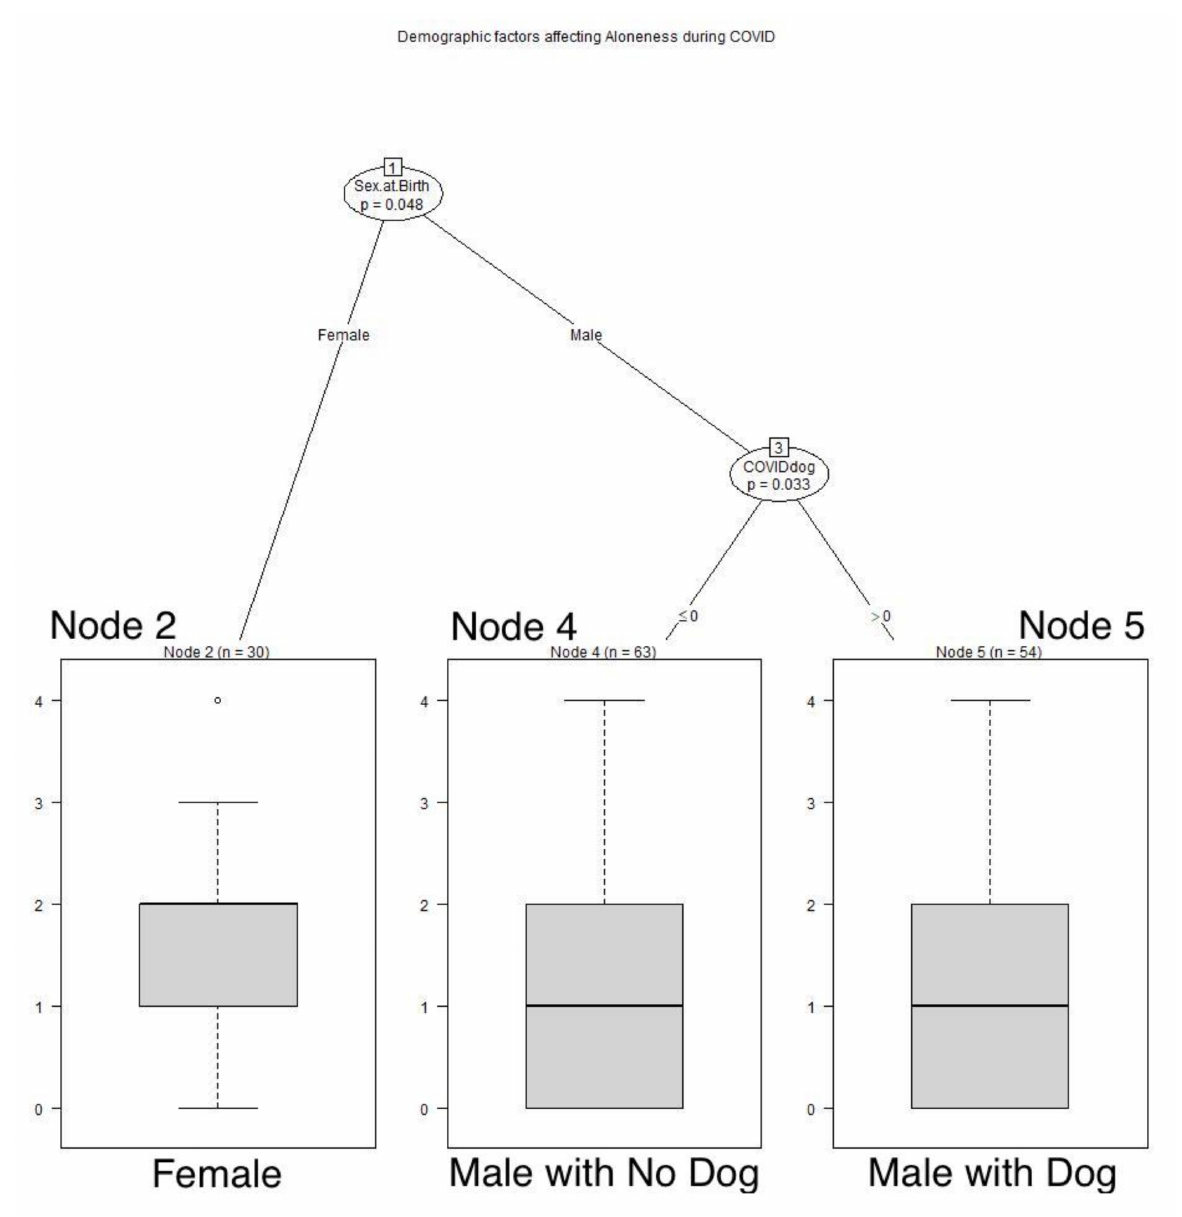
Figure 3. Demographic factors affecting aloneness during COVID . Male respondents felt alone less frequently than females, and men with dogs felt alone even less frequently than men without dogs: Node 2: x − = 1.7, SD 1.0554; Node 4: x − = 1.444, SD 1.2152; Node 5: x − = 0.98, SD 1.072.